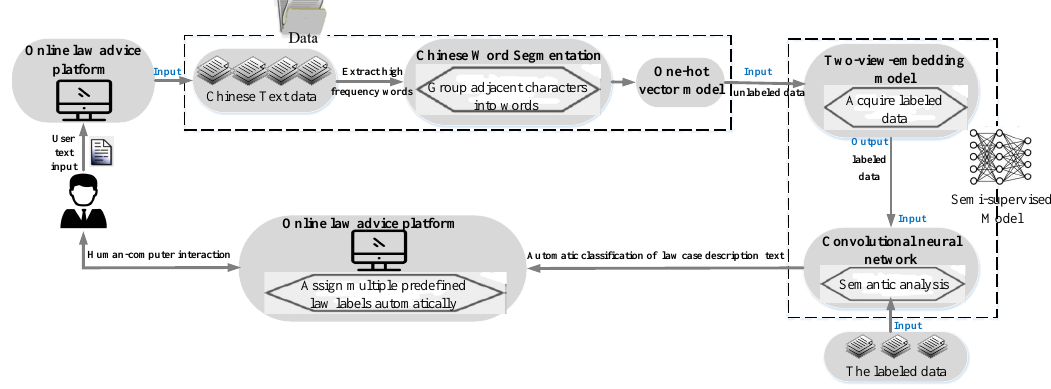
Figure 1. The flowchart of the online law advice